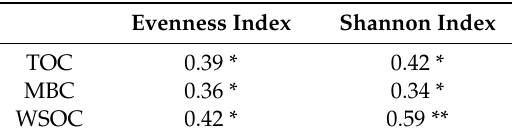
CH5, CH10, Ch15, CH20: Chinese hickory under 5-, 10-, 15-, 20-year intensive management, respectively; NMF: natural Chinese hickory–broad-leaved mixed forest. Different letters in the same column indicate significant difference at p < 0.05 ( n = 3). Table 6. Correlation between microbial carbon source usage diversity and soil organic carbon contents in Chinese hickory stands managed intensively for 5, 10, 15, and 20 years, and in Chinese hickory–broad-leaved mixed forest stands.